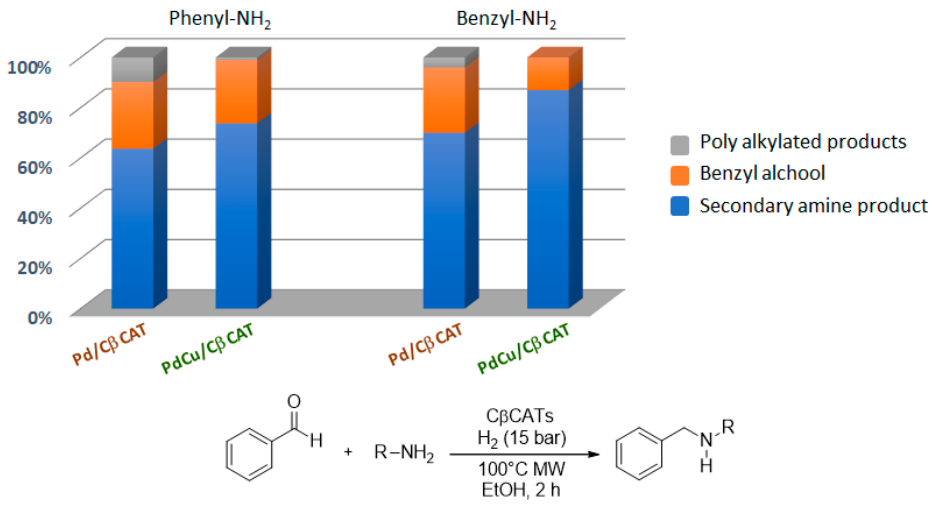
Figure 3. Influence of the co-metal on the bimetallic catalyst performance and selectivity.